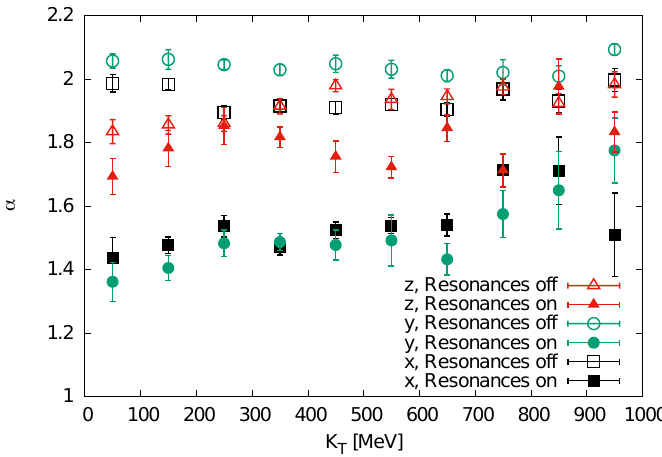
Figure 3. The Lévy parameter α from 1D fits to the correlation function in q inv along the different axes, with or without resonances. Vertical error bars show the 1 σ intervals, resulting from fitting the correlation function with the ansatz of Equation